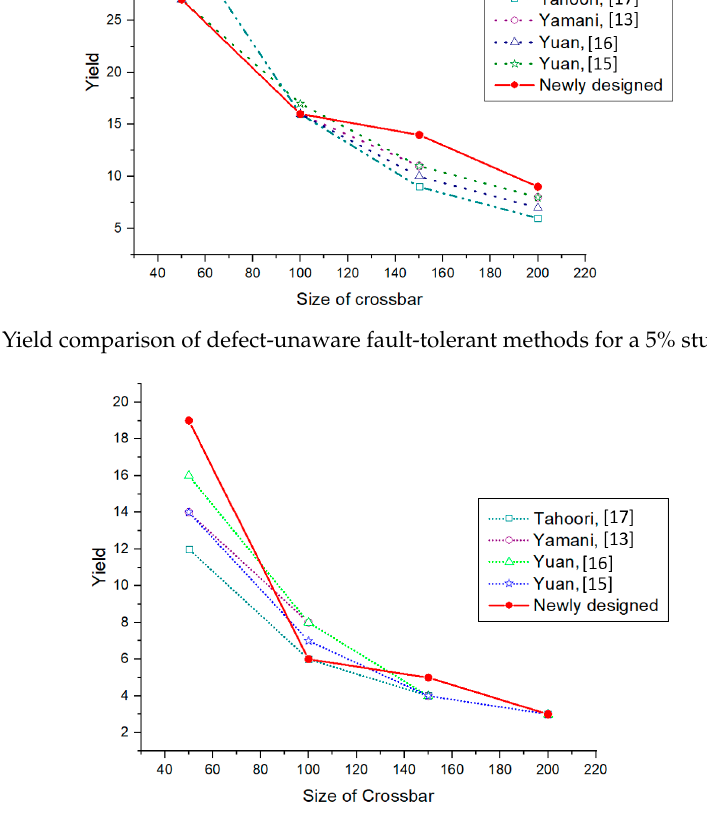
Figure 8. Yield comparison of defect-unaware fault-tolerant methods for a 10% stuck-at-off fault.